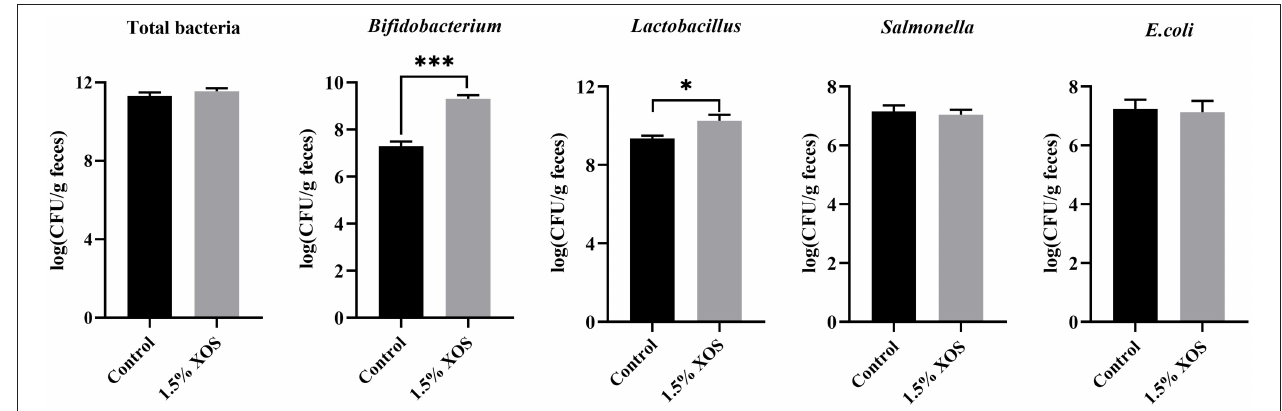
FIGURE 2 | Effect of XOS on specific bacteria in feces. Data are presented as means + SEM. * P < 0.05 and *** P < 0.001, n = 6 for each group.